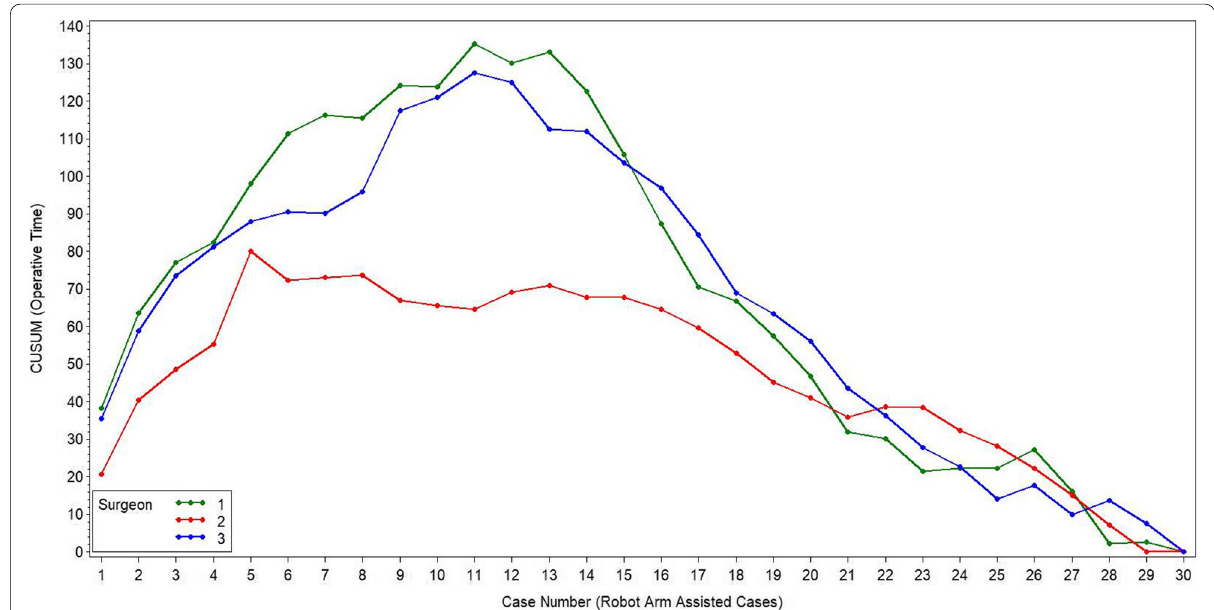
Fig. 6 The cumsum figure shows the cumulative sum of the differences of the operating times compared to the average operating time for raTKA for each of the surgeon’s cases